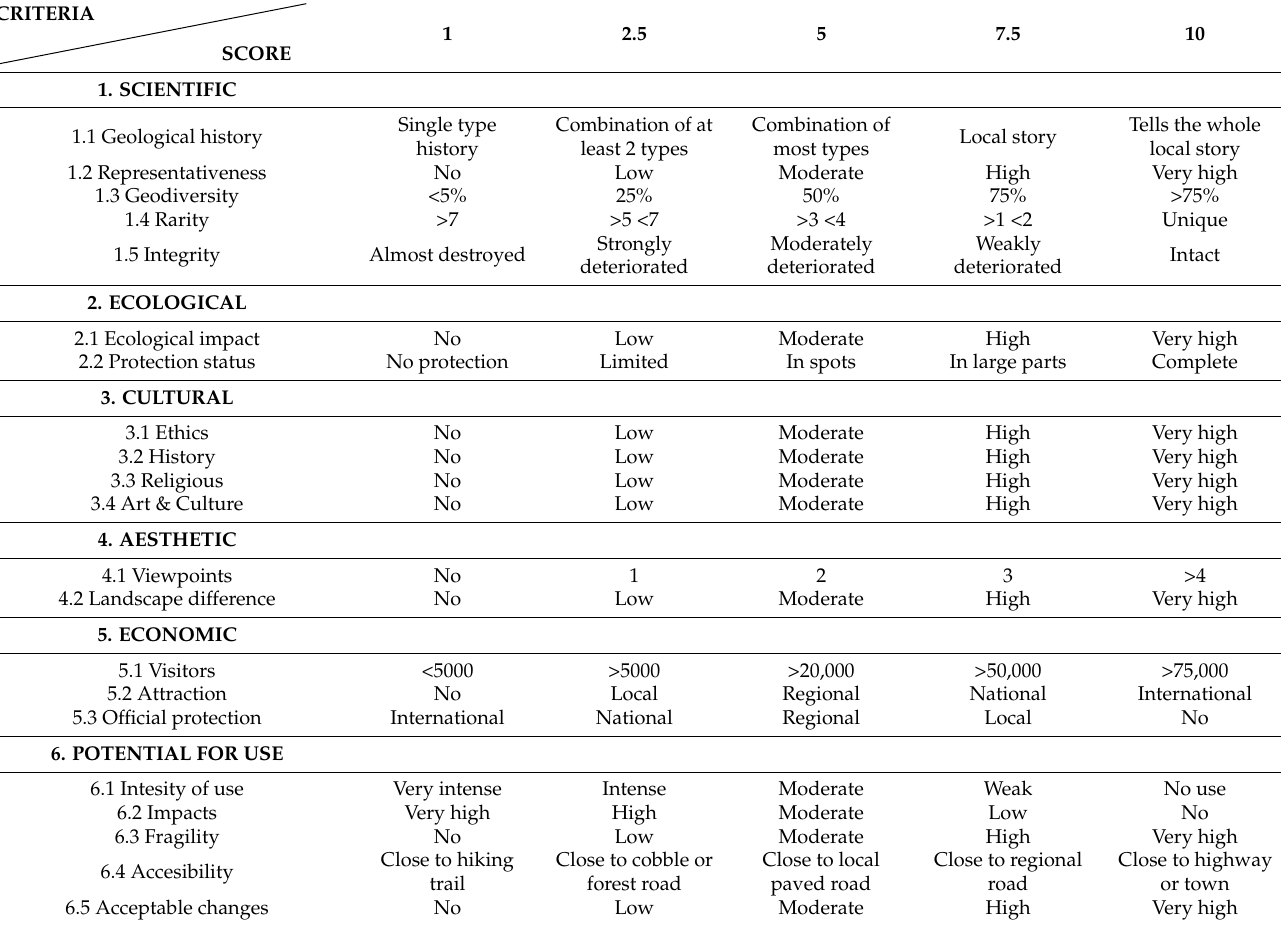
Table 3. List of criteria and description of the scoring system